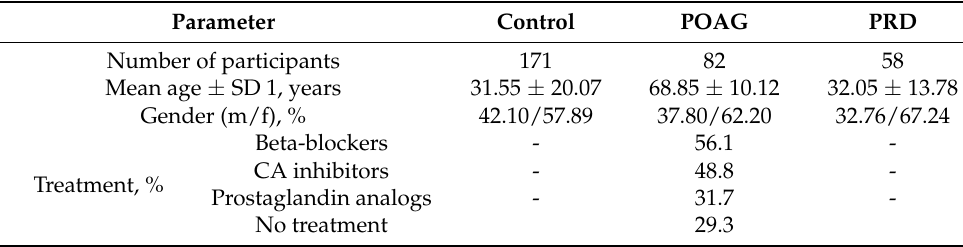
Table 1. Characteristics of experimental